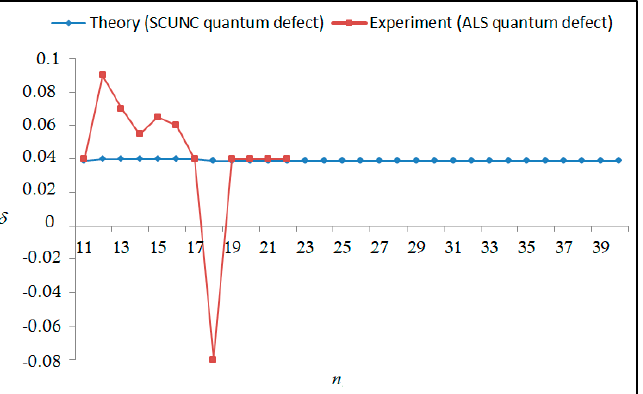
Figure 3. Variations of the quantum defect ( δ ) with the principal quantum number n for the 4 s 2 4 p 2 ( 3 P 2 ) nd Rydberg series originating from the 2 P ° 3/2 metastable state of Se + converging to the 3 P 2 series limits in Se 2+ .